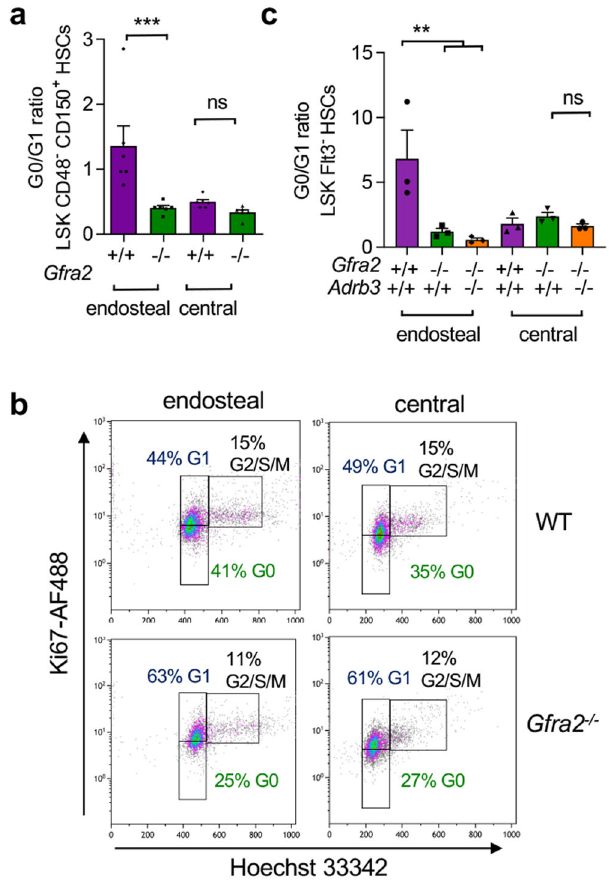
Fig. 2 Cholinergic signals promote HSC quiescence in endosteal BM niches. a Ratio of quiescent HSCs (G0:G1 phases of the cell cycle) in the endosteal or central BM of Gfra2 − / − or WT mice ( N = 6; P = 0.0006). b Representative fl ow cytometry diagrams showing ki67/Hoechst 33342 of lin − sca1 + ckit + (LSK) CD48 − CD150 + HSCs isolated from the endosteal or central BM of Gfra2 − / − mice or control Gfra2 + / − mice ( N = 6). The frequencies of the gated populations are indicated. c Ratio of quiescent HSCs in the endosteal or central BM of Gfra2 − / − , Adrb3 − / − , compound Gfra2 − / ;Adrb3 − / − or WT mice ( N = 3; P = 0.006). a , c Each dot is a mouse. Data are mean of biological replicates ± SEM. * P < 0.05, ** P < 0.01, *** P < 0.001. ANOVA and Bonferroni ’ s multiple comparisons